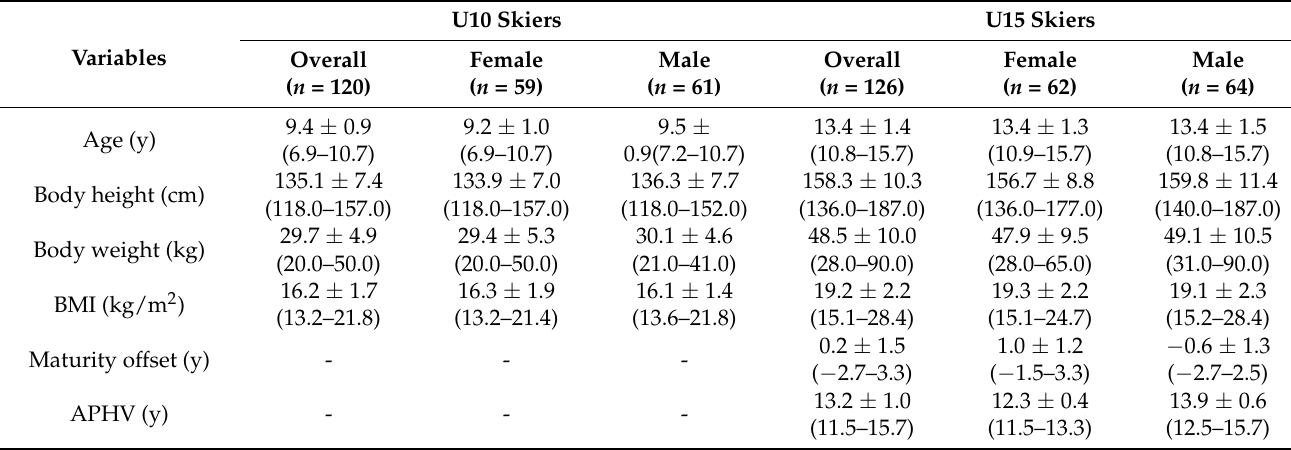
Table 1. Baseline and biological maturation data for skiers under 10 years old (U10) and those under 15 years old (U15) separated by